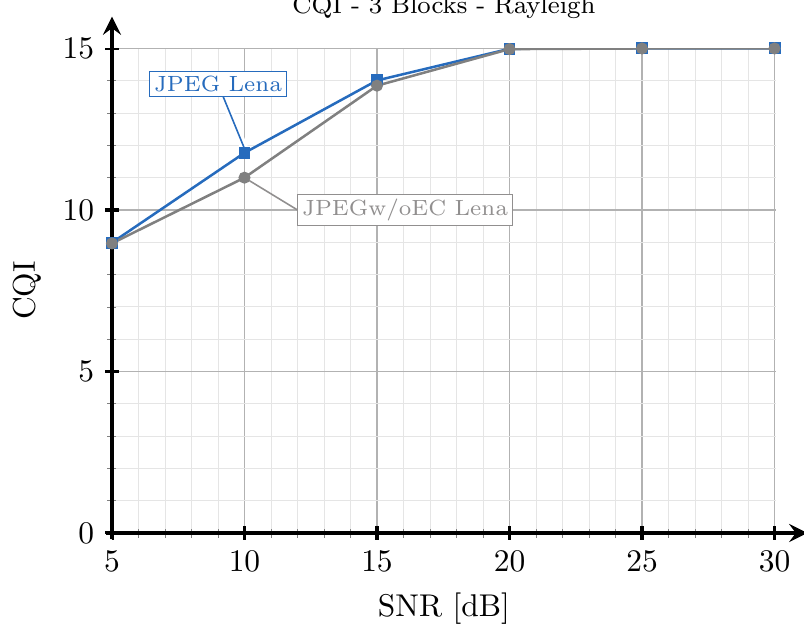
Figure 12. Channel quality indicator CQI vs. SNR for 3 blocks and Rayleigh